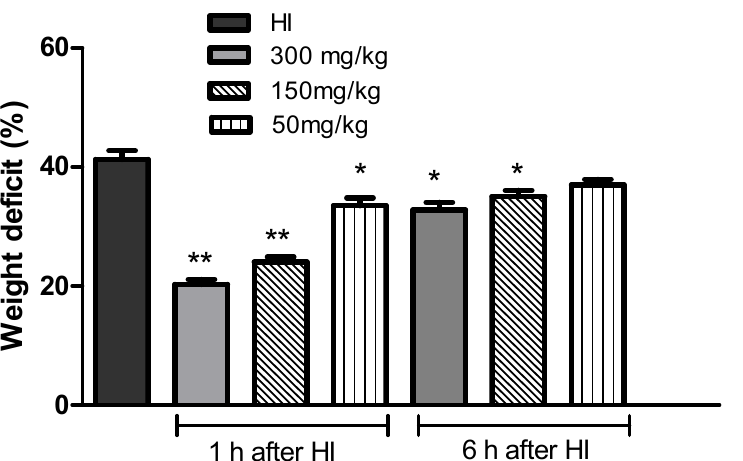
Figure 1. Effect of the application of KYNA on the weight deficit of the ipsilateral hemisphere after HI. KYNA (at all tested doses) was applied i.p. 1 h or 6 h after HI insult. The weight deficit is expressed as the percentage of the weight of the contralateral (right) hemisphere. The results are presented as the mean ± SEM, n = 4–9; * p < 0.05, ** p < 0.01 compared to the HI group. Histological analysis upon HI treatment showed, expectedly, marked cell loss in the cortex, and damage and disorganization of neurons in the CA1 region of the hippocampus in the HI group (Figure 2A–C). The number of surviving neurons observed in the central part of the CA1 region was reduced by 55% (Figure 2B), and by 75.6% in the cortex (Figure 2C), compared to the control.